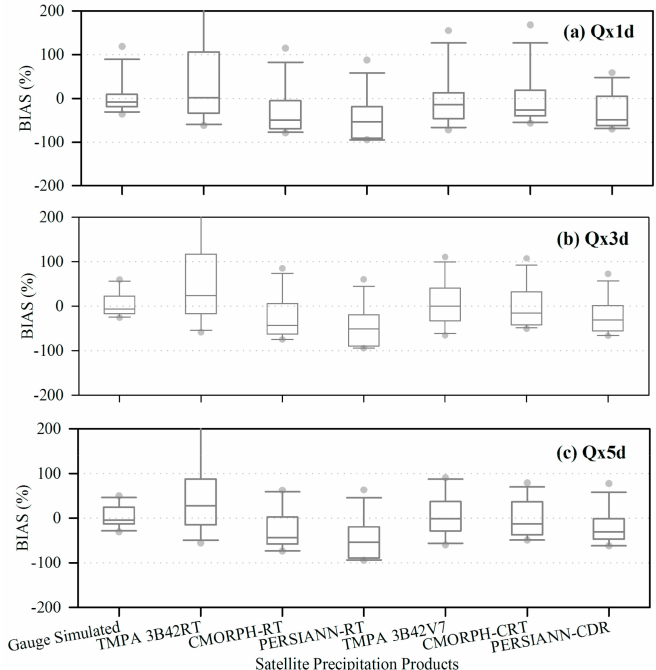
Figure 7. Box plots of the BIAS index of the annual maximum ( a ) 1-day streamflow; ( b ) 3-day streamflow and ( c ) 5-day streamflow for the six SPPs-based simulations versus the hydrological station observations over 14